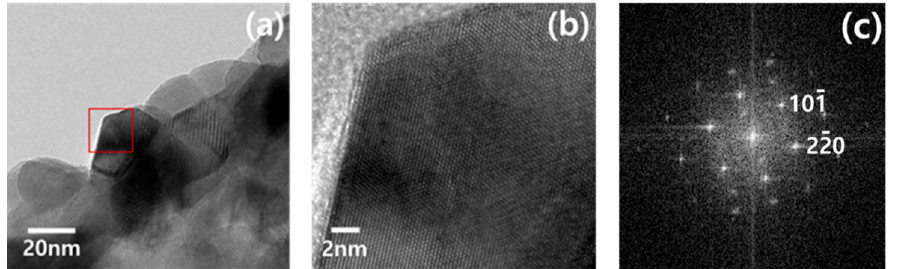
Figure 7. High-resolution transmission electron microscopy (HRTEM) analysis of particles on the surface of Fe-doped TiO 2 nanofibers: ( a ) BF image of the particle, ( b ) HRTEM image of the particle, and ( c ) FFT patterns of the particle.